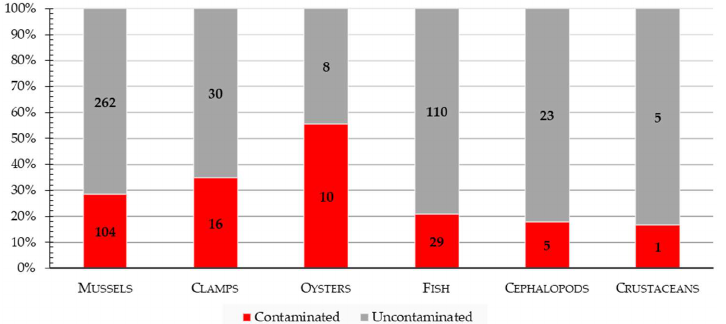
Figure 1. Bar graph showing the percentage of samples contaminated by Vibrio spp. Per each group enlisted.